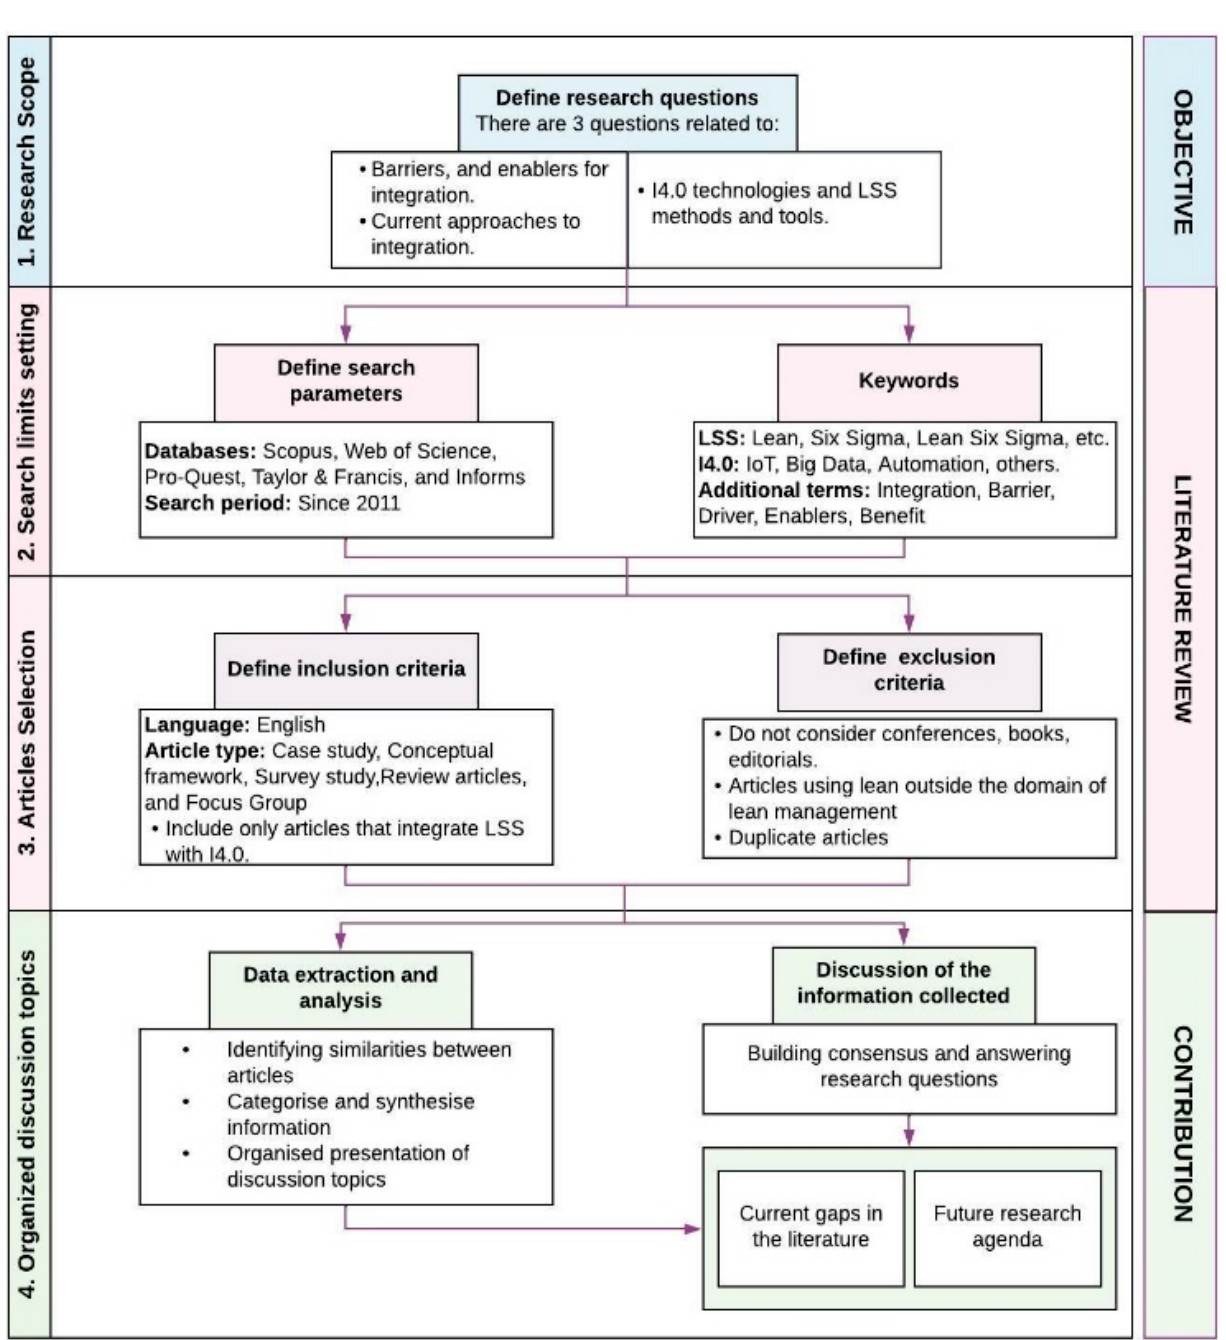
Figure 2. Literature review structure.